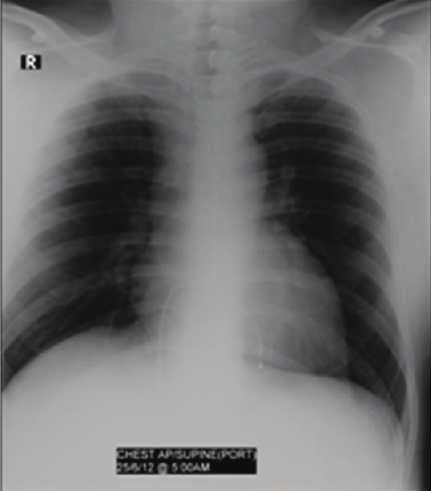
Figure 4: CXR shows cardiac enlargement and pulmonary venous congestion. Temporary pacing lead is seen positioned in the right ventricle. There is no hilar lymph